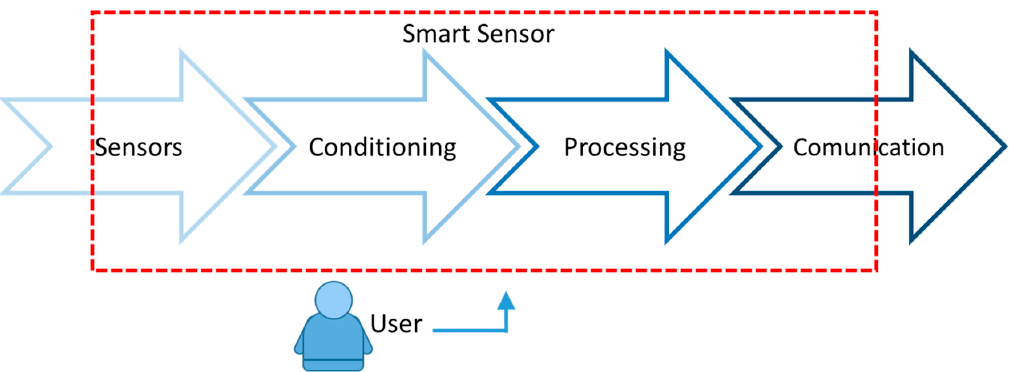
Figure 2. Summarized flowchart of a smart sensor.